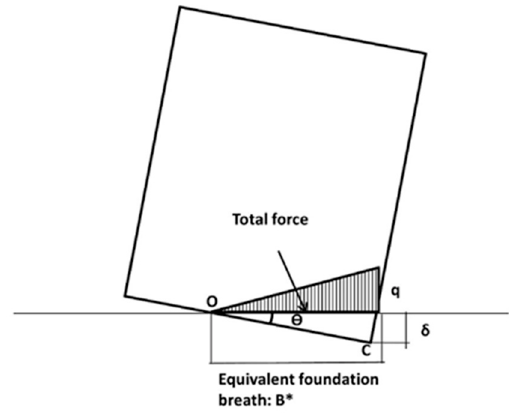
Figure A3. Definition of equivalent foundation breath.